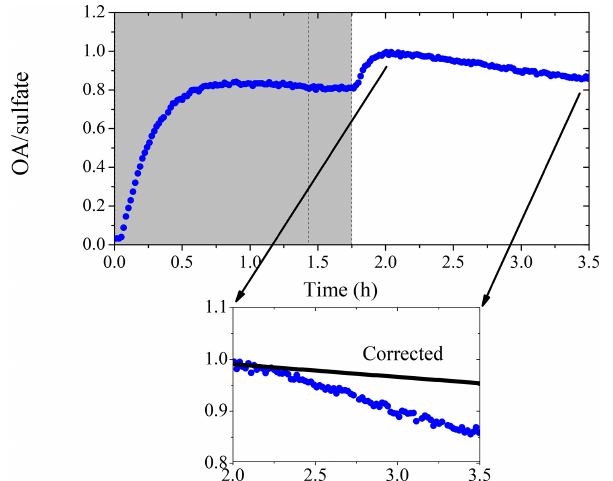
Figure 7. (a) The AMS-measured organic (green) and sulfate (red) mass distribution ( D va from 75 to 600nm) for Exp. 4; (b) the de- pendence of the AMS-derived organic to sulfate ratio on particle vacuum aerodynamic diameter (75–600nm). The results are based on particle time-of-flight data averaged over ∼ 1 . 4h ( t = 2 .